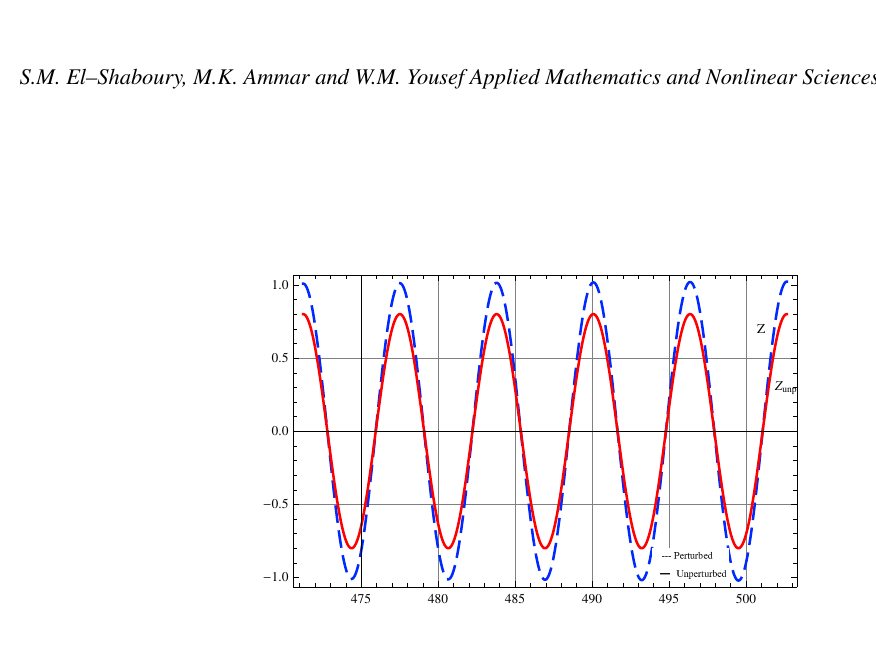
Fig. 4 Perturbed and unperturbed z-component of the deputy relative position vs. Chief true anomaly.